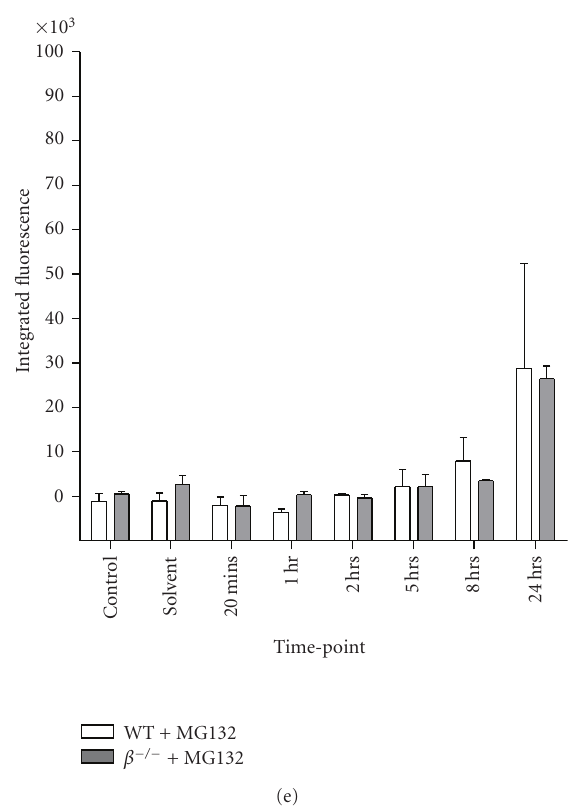
Figure 6: TARDIS analysis of cells treated with etoposide continuously for 24 hours plus and minus MG132 or with MG132 alone. Topoisomerase II-DNA adducts were quantified using an antibody that detects both isoforms. WT MEFs following exposure to 1 μ M ± 2 μ M MG132 (a), Top2 β − / − MEFs following exposure to 1 μ M ± 2 μ M MG132 (b), WT MEFs following exposure to 10 μ M ± 2 μ M MG132 (c), Top2 β − / − MEFs following exposure to 10 μ M ± 2 μ M MG132 (d), or WT and TOP2 β − / − MEFs following exposure to 2 μ M MG132 alone (e). Plots show the mean of the median FITC